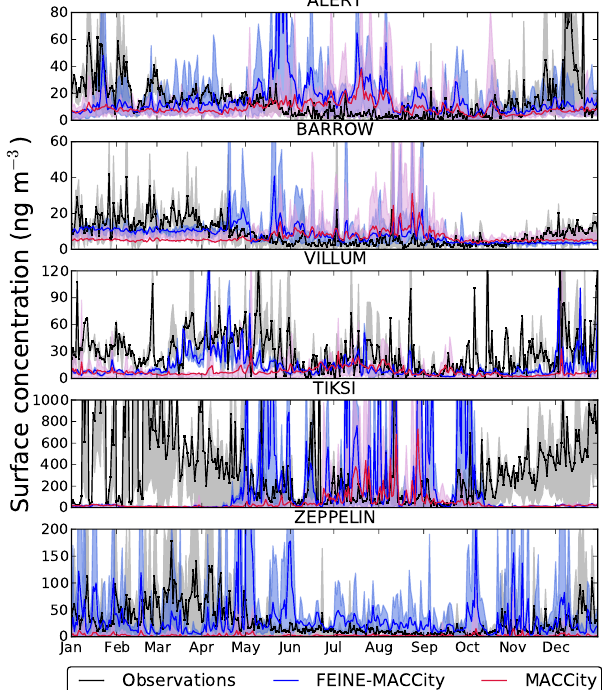
Figure 7. Modelled vs. measured surface concentrations of BC (ngm − 3 ) for the FEI-NE + MACCity and MACCity simulations in the Arctic stations Alert, Barrow, Villum, Tiksi, and Zeppelin. Due to the high variability of the surface concentrations, the re- sults are presented as minimum, average, maximum modelled (FEI- NE + MACCity and MACCity) and measured surface daily concen- trations of BC for the period